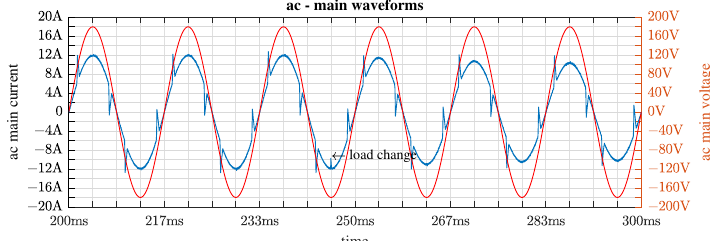
Figure 12. Ac-main electrical waveforms: current (blue) and voltage (red).